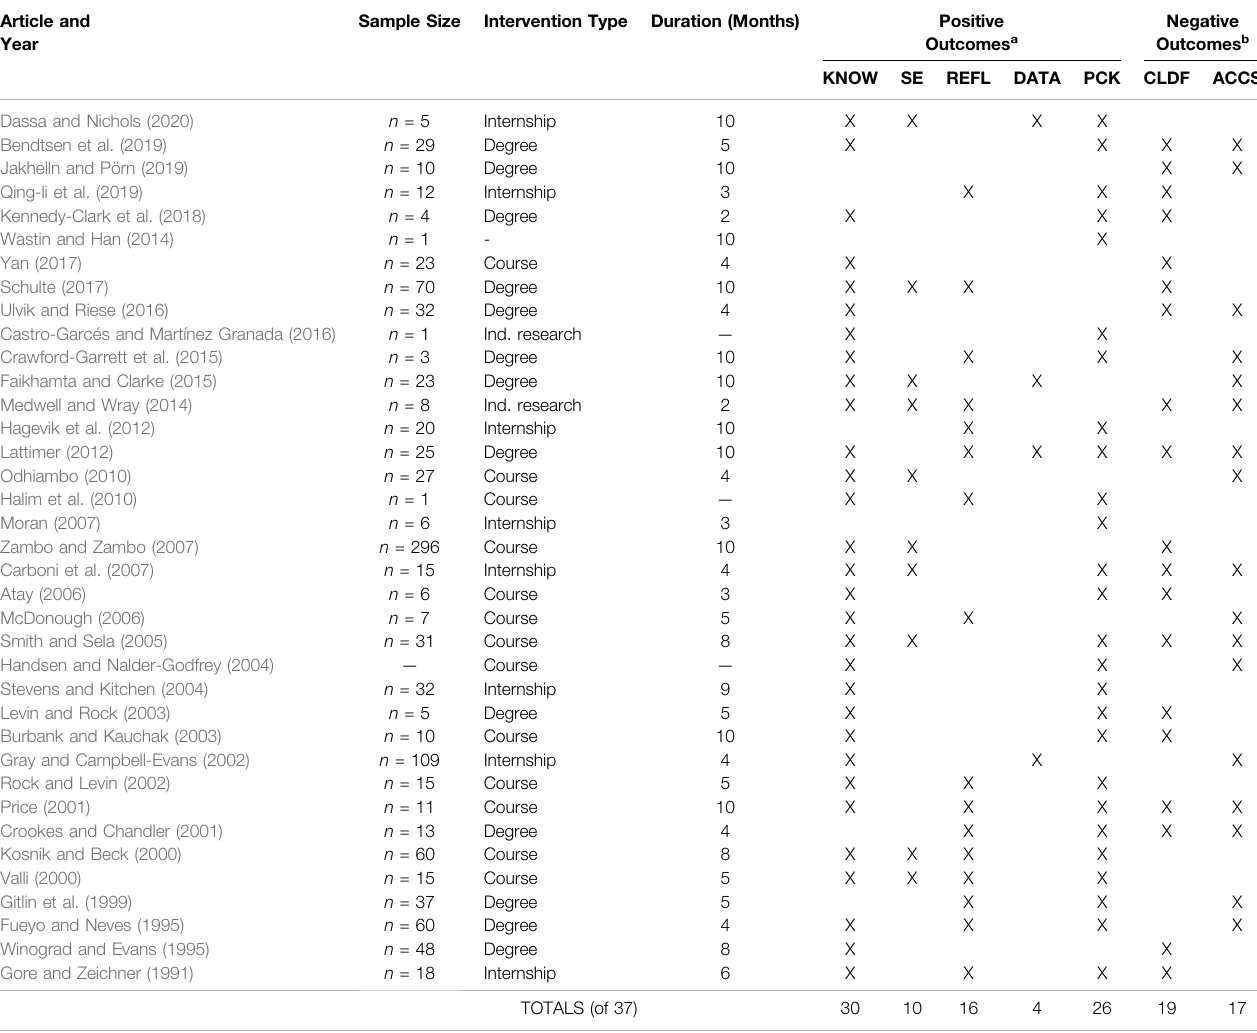
TABLE 1 | Literature review: Positive and negative outcomes of teacher involvement in action research. Article and